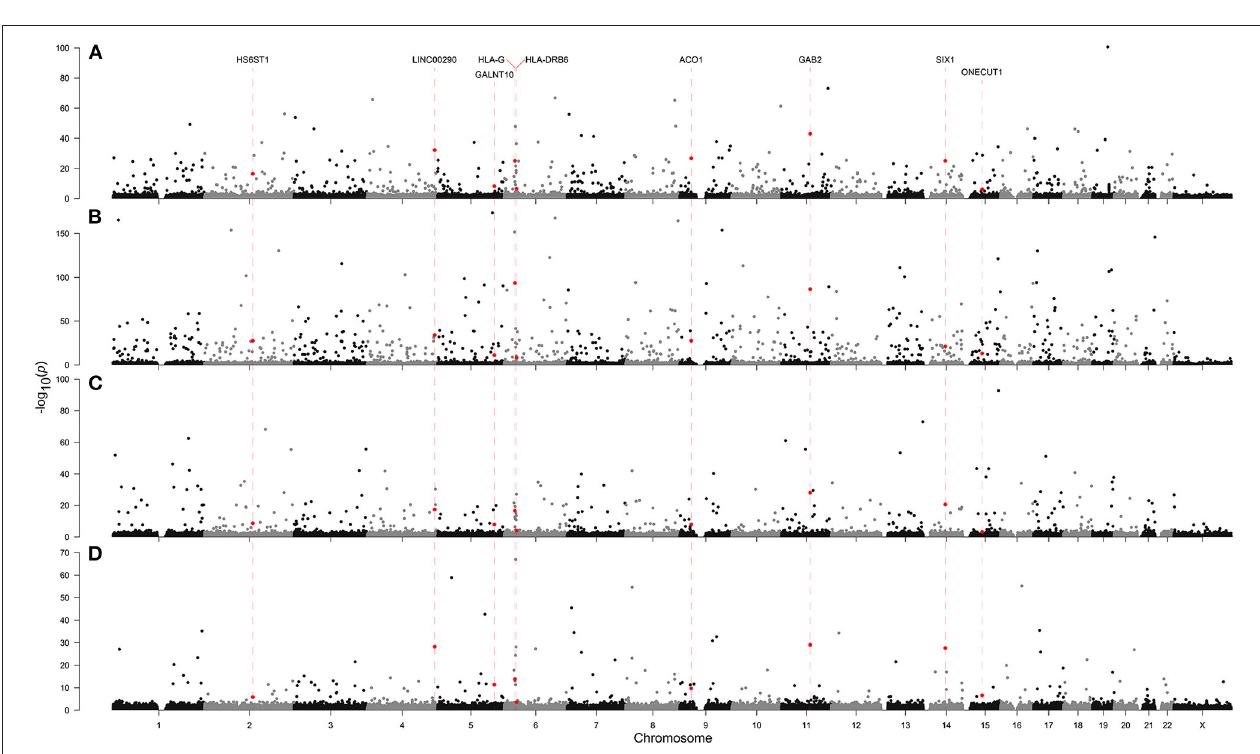
FIGURE 2 | (S) Prospective memory result (second visit). (T) Prospective memory result (third visit). Data represent all participants, including those whose samples which were not used in the training or testing of the multinomial model. AD, Alzheimer’s disease ( n = 152); PD, Parkinson’s disease ( n = 948); MND, motor neuron